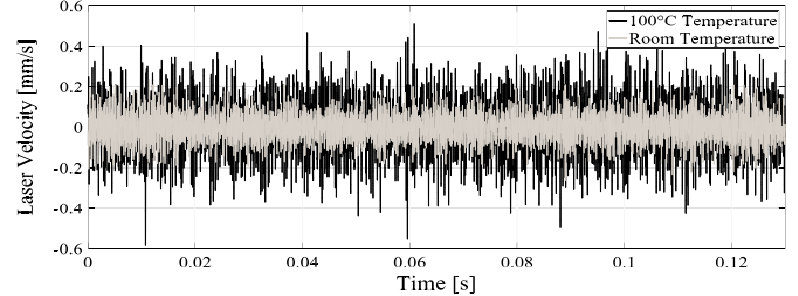
Figure 4. Comparison of the laser velocity test at room temperature and laser velocity test at 100 °C.